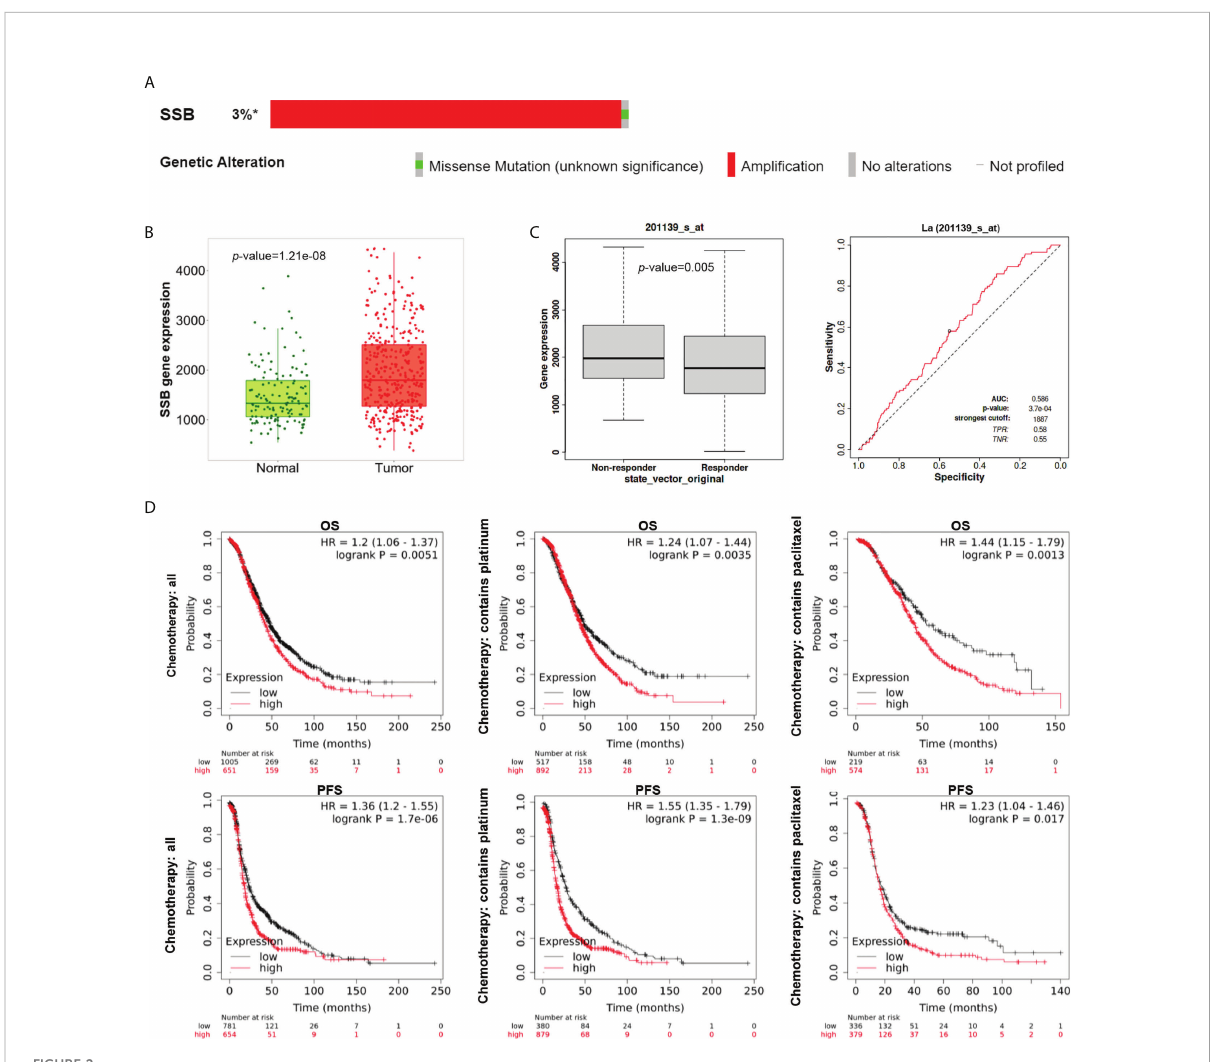
FIGURE 2 Expression, alternation, and prognostic analysis of La in ovarian cancer by bioinformatics analysis. (A) The alterations of the La gene in ovarian cancer (cBioPortal). La gene was examined in all fi ve ovarian cancer studies with >3% gene alterations. (B) The mRNA expression pattern of La from TNMplot between ovarian cancer tissues (red) and normal samples (green) from non-cancerous patients and further pediatric tissues. (C) Boxplot and ROC curve of La involved in platinum resistance using the RFS at 6 months cohort from the ROC plotter for ovarian cancer (Affymetrix ID: 201139_s_at). (D) The prognostic value of mRNA level of La in ovarian cancer patients from the KM plotter (Affymetrix ID: 201139_s_at). *, altered / pro fi led=49 /